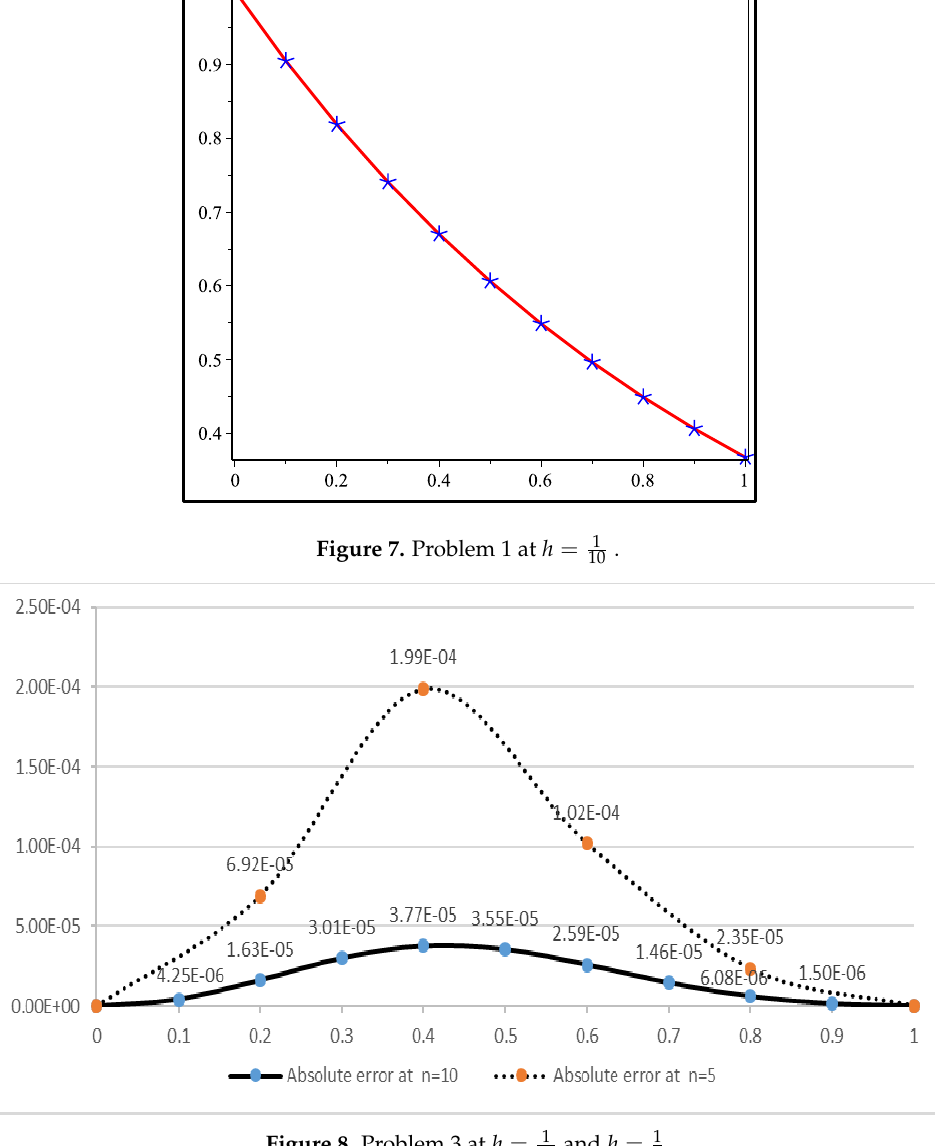
Figure 8. Problem 3 at h = 1 Table 9. Analyzing exact solution and CBS solution of problem 3 at h = 1